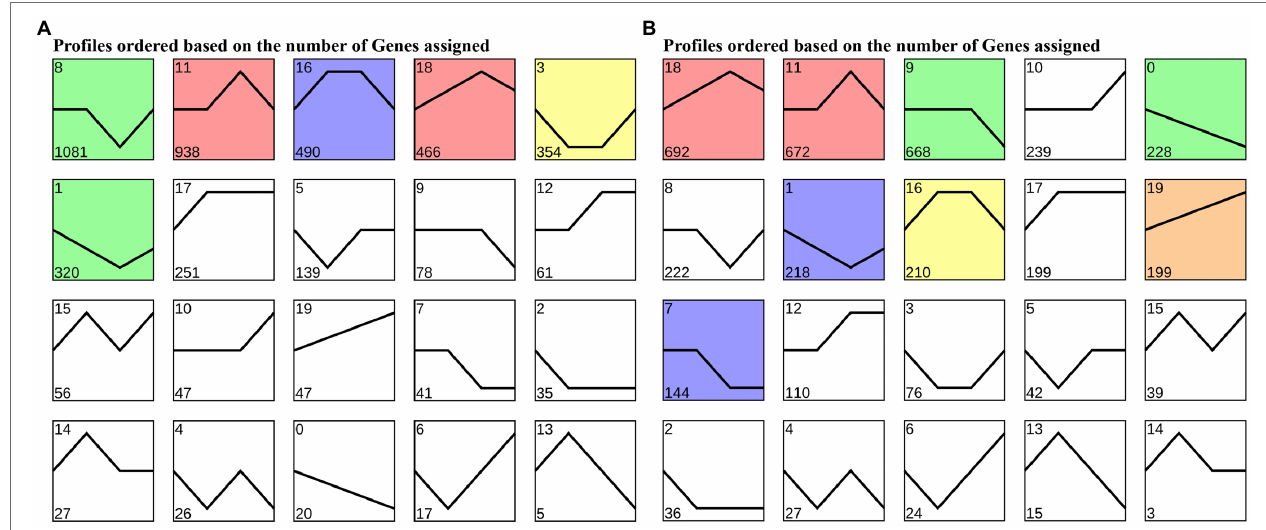
FIGURE 4 | Trends in expression levels of differentially expressed genes in leaves of “Gannong NO.3” (A) and “WL326GZ” (B) in response to freezing